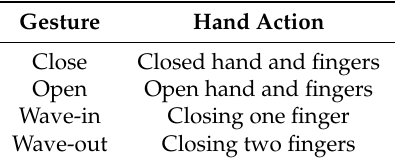
Table 5. Mapping between the trained gestures and hand